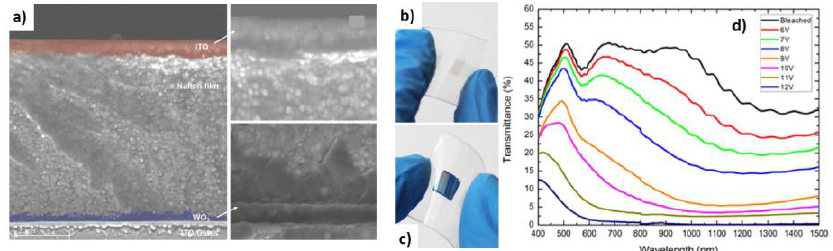
Figure 6. ( a ) Scanning electron microscopy image of the cross-section of a solid-state EC device. ( b , c ) Pictures reporting the device fabricated on polyethylene naphtalate flexible substrates, in bleached